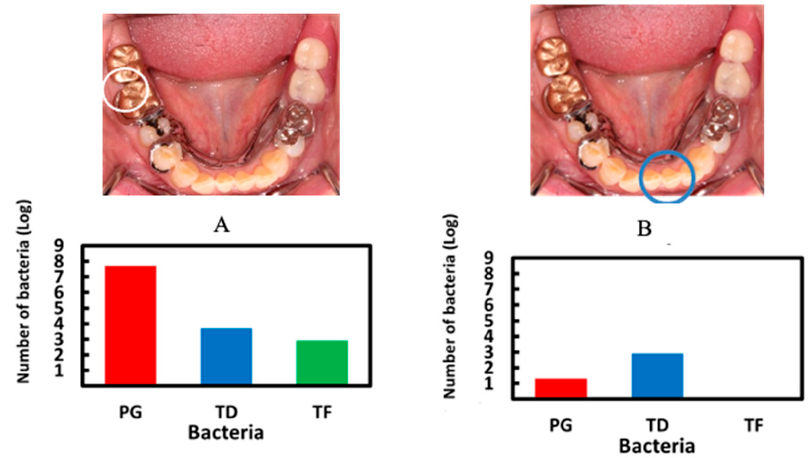
Figure 11. Bacterial number profiles between deepest ( A ) and shallowest ( B ) pockets. White and blue circles indicated deepest and shallowest pockets, respectively. PG, TD and TF were periodontal bacteria.